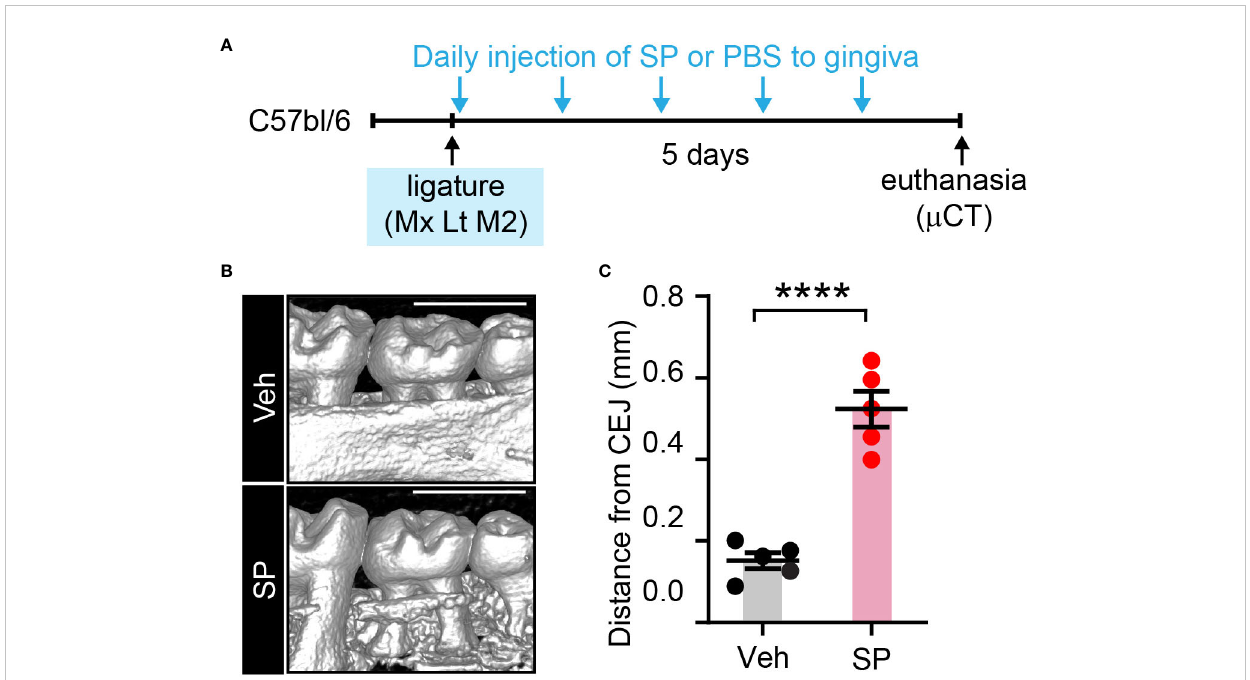
FIGURE 9 Exogenous substance P aggravates ligature-induced periodontitis. (A) Time course of the experiment. Under iso fl urane anesthesia, SP (1 µg/site) or vehicle (PBS) was injected twice a day into two sites in the gingiva around the maxillary second molar; one site between the fi rst and second molars, and the other site between the second and third molars) for fi ve days after placing the ligature. (B) µCT examination of a periodontium fi ve days after ligature placement with Veh or SP injection. Scale bar, 1 mm. (C) Quanti fi cation of bone height loss. ****p<0.0001 in Student ’ s t-test. N=5 per group. CEJ, cement-enamel